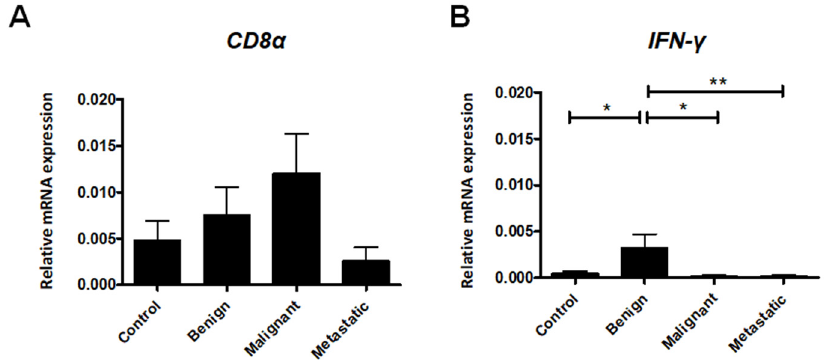
Figure 2. Relative gene expression of CD8 α ( A ) and IFN- γ ( B ) in healthy mammary gland tissue (Control) and in benign, malignant, and metastatic canine mammary tumors. The results are presented as the mean ± SEM. A one-way ANOVA and Tukey HSD post hoc test were applied. Significance levels are indicated as follows: * p < 0.05; ** p < 0.01; *** p < 0.001.